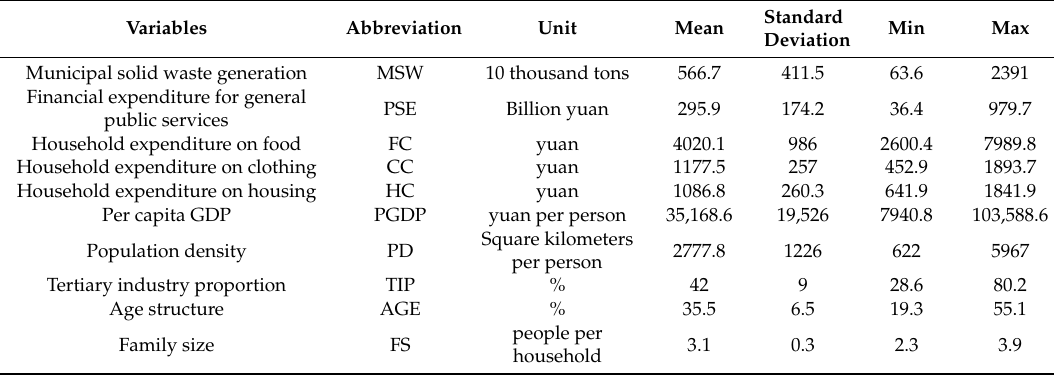
Table 3. Description of statistical characteristics of